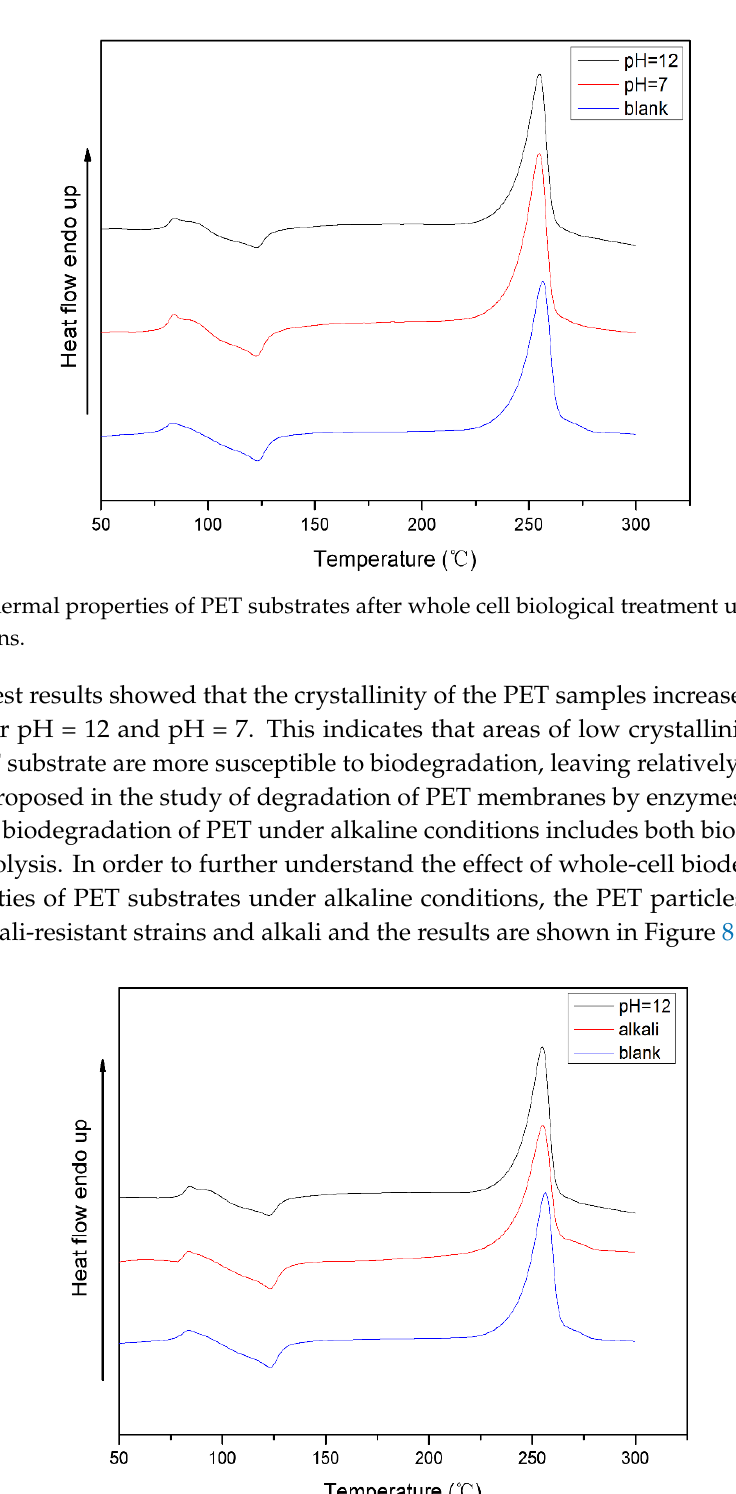
Table 3. Thermodynamic properties of PET samples.